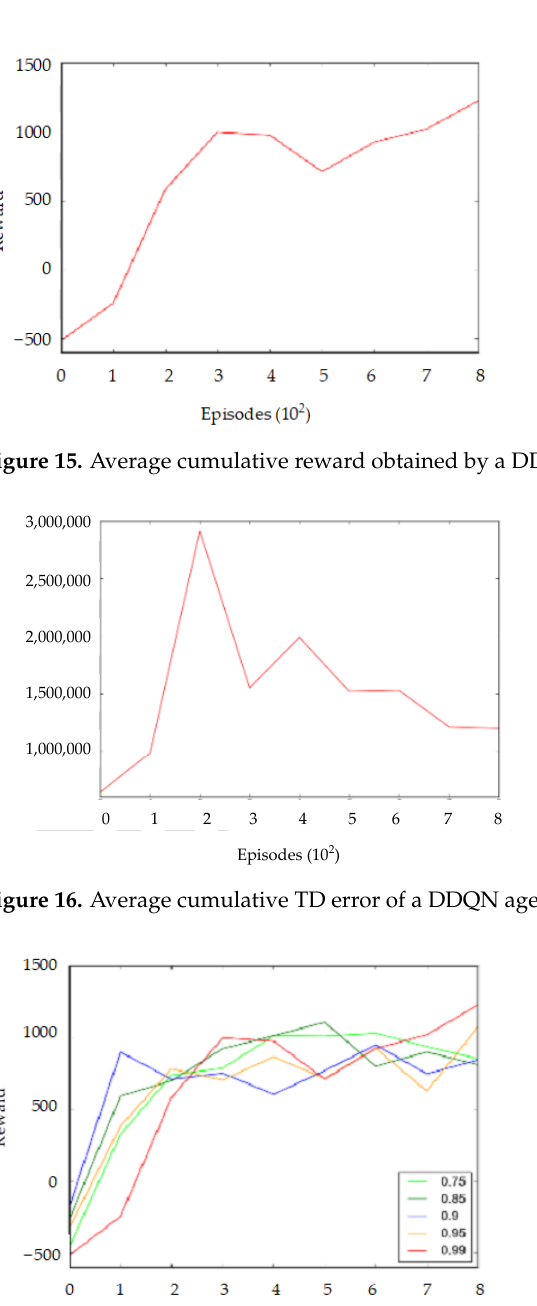
Figure 14. Average cumulative reward obtained by a DQN agent for different discount factor values in the Gazebo simulator.